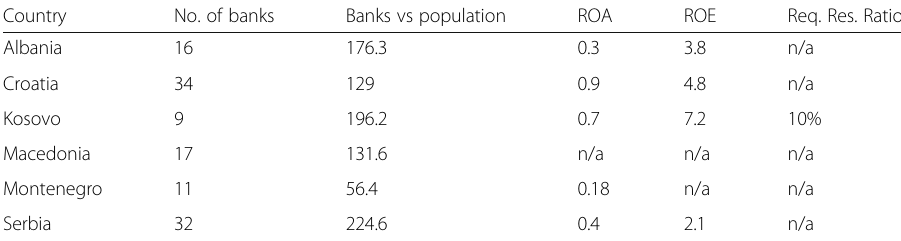
Table 6 Distribution of banks per population Country